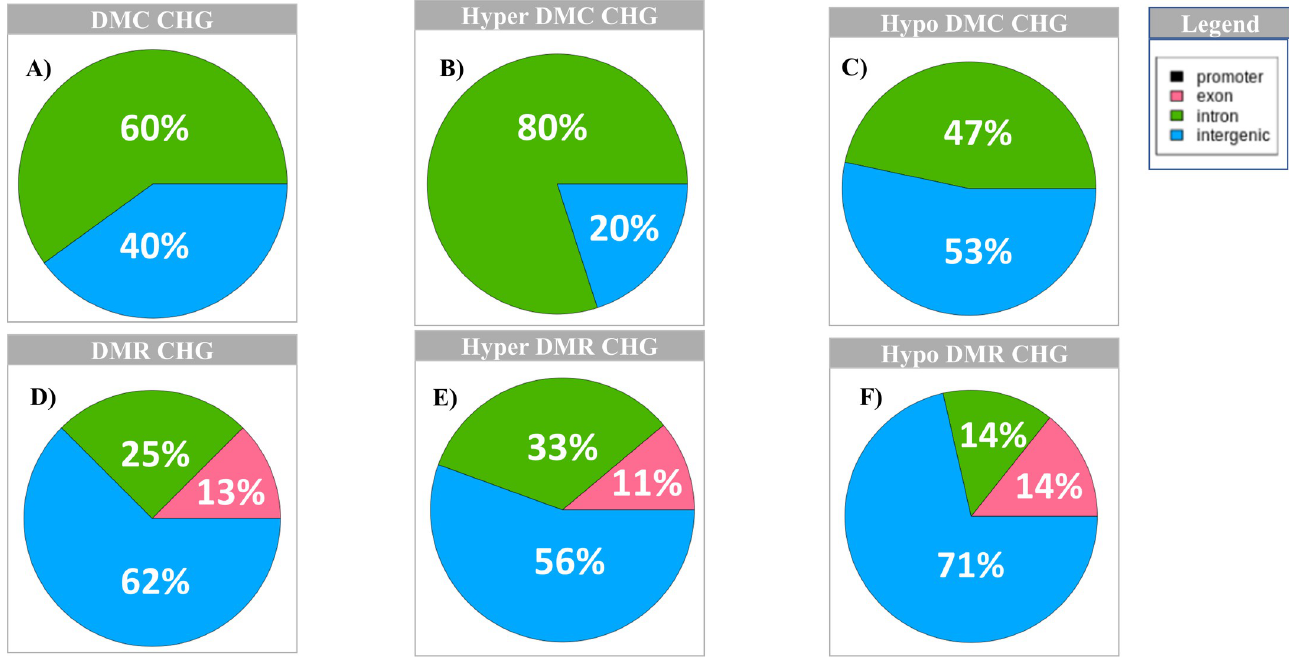
Fig 3. Distribution of CHG DMC and DMR across the different genomic regions. A) Distribution of DMC CHG; B) Distribution of hyper DMC CHG; C) Distribution of hypo DMC CHG; D) Distribution of DMR CHG; E) Distribution of hyper DMR CHG; F) Distribution of hypo DMR CHG; Legend: black = promoter region; pink = exon; green = intron and blue = intergenic regions.